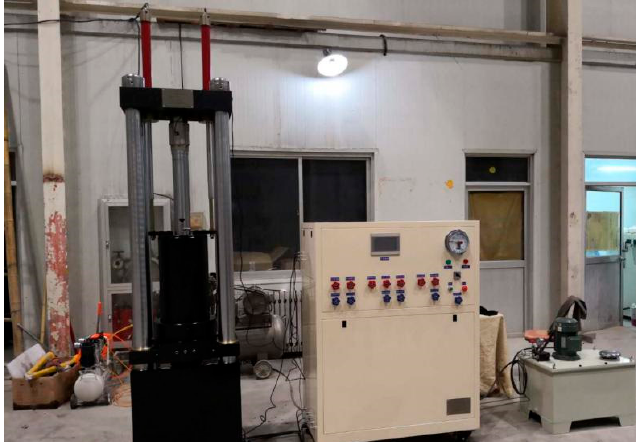
Figure 10. Rock triaxial (creep) tester.